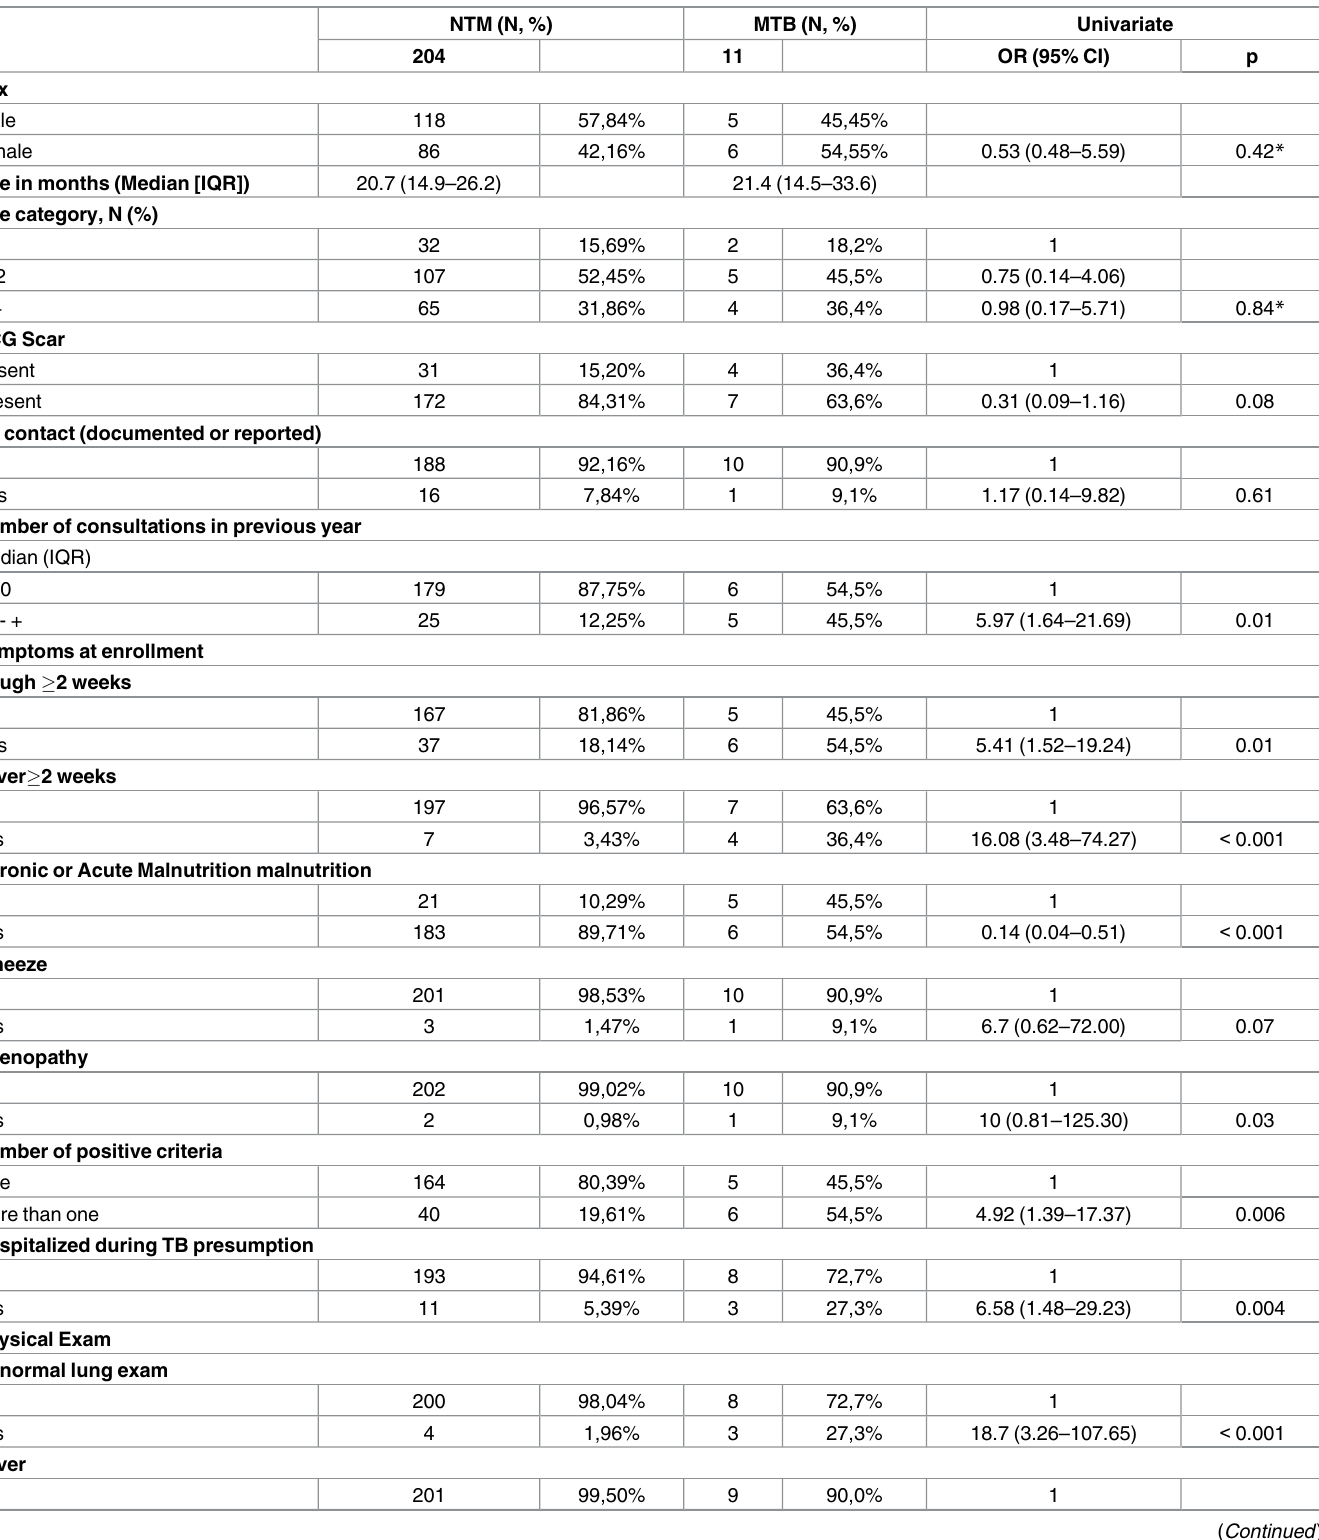
Table 3. Baseline characteristics of presumptive TB cases with at least one sample at admission according to mycobacterial culture